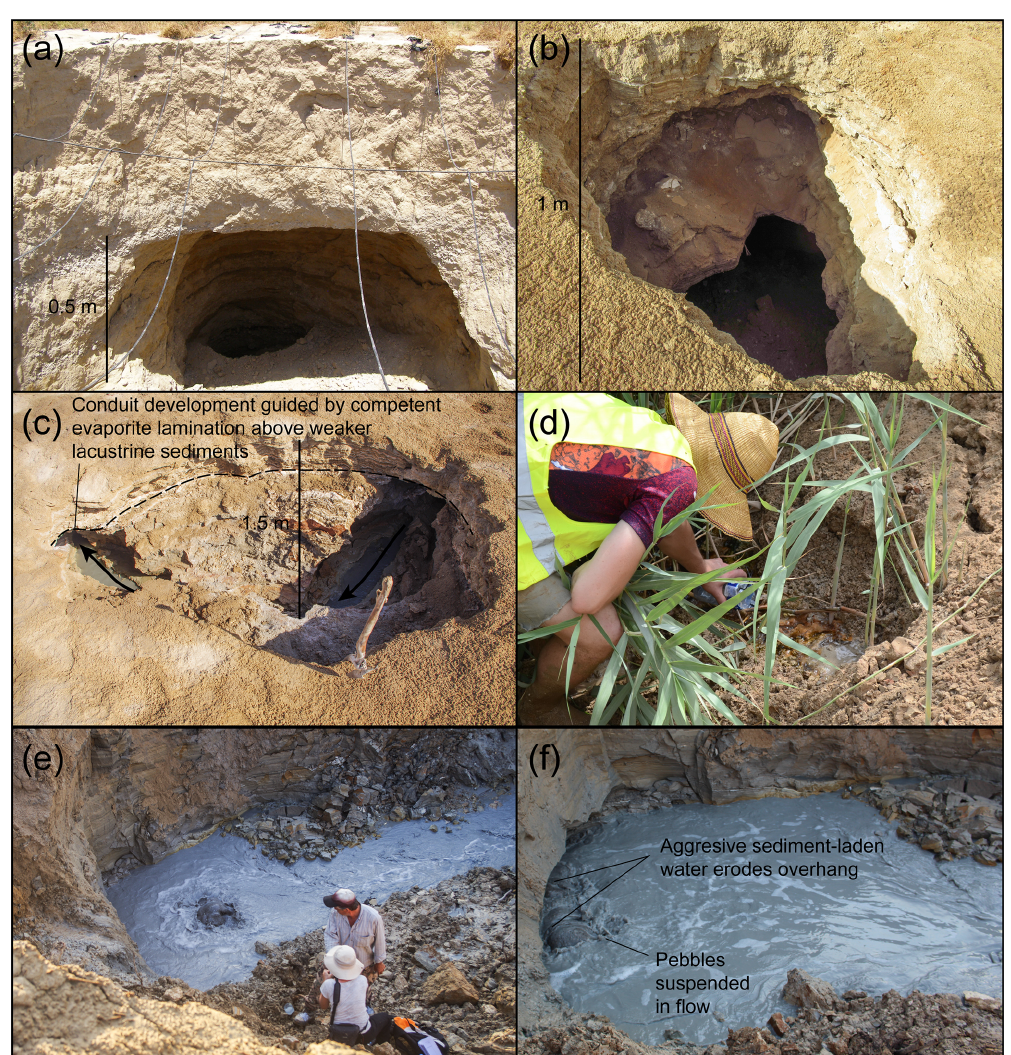
Figure 8. Field impressions of conduits and karstic groundwater springs at Ghor Al-Haditha. (a) Nested sinkhole in the alluvium (located in the southern part of the uvala) intersecting a further cavity or pipe. Photo: Damien Closson, 2008. (b) Sinkhole in lacustrine mudflats (located just inland of CM7; photo taken 2018) with pipe disappearing toward the top of the picture. (c) Conduit formed in lacustrine mudflat deposits near to the shoreward termination of CM1 (photo taken 2014). The flow has excavated a conduit in the weaker mud deposits below a more competent evaporite lamination. (d) Spring s 4 at CM5 at baseflow rate (estimated discharge: 2 × 10 − 4 m 3 s − 1 ). The main stream is fed by several similar seeps within the depression at the channel head. Photo taken: 2018. (e) s 4 during high flow 3d after an intense rainfall event (estimated discharge: 2 × 10 − 1 m 3 s − 1 ). Photo taken: 2015, modified after Al-Halbouni et al. (2017). (f) Close-up of s 4 during high flow. The nature of the sediment load varies from fine sediments to pebble-sized clasts (up to 5cm in diameter). Photo taken: 2015, modified after Al-Halbouni et al.